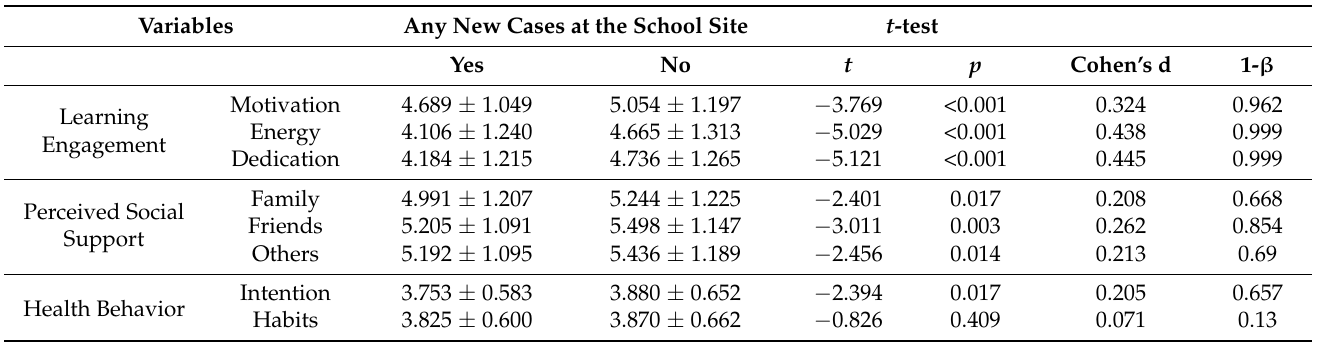
Table 4. Variance analysis report